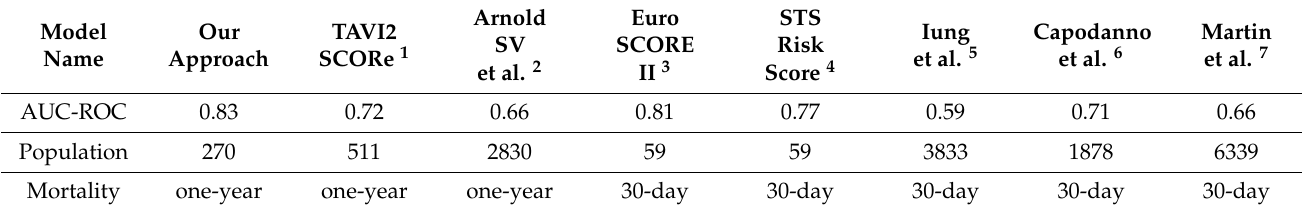
Table 6. Performance analysis with respect to other mortality predictors assessed on data from other centers and available in the